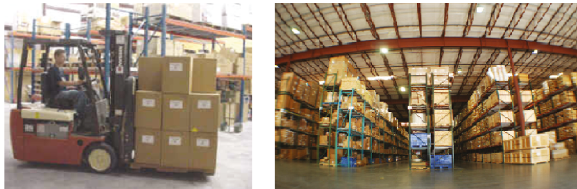
Figure 2: Di ff erent application scenarios requiring di ff erent read- out delay and throughput to be e ffi